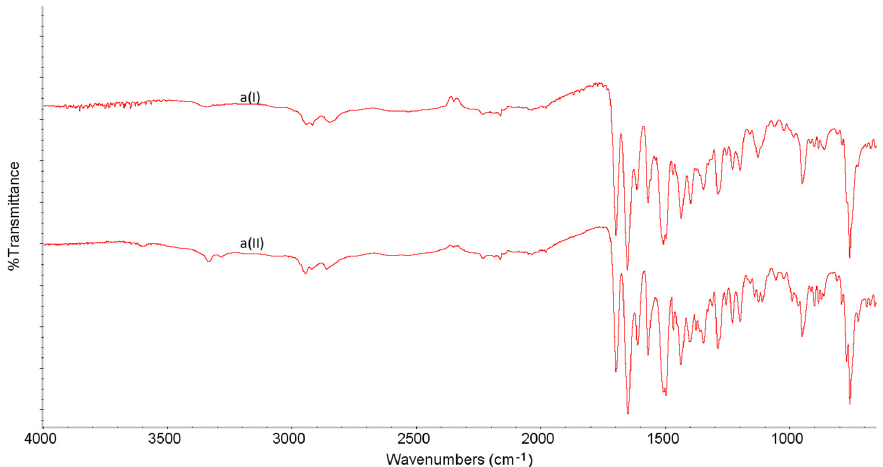
Figure 4 . FT-IR spectra for linagliptin (a) in the non-stressed (I) and stressed (II) samples. Figure 4. FT-IR spectra for linagliptin (a) in the non-stressed (I) and stressed (II) As far as excipients are concerned, LAC, MAN and MGS did not show changes under stress conditions. However, slight changes were observed in the spectrum of PVP, espe- cially in the region 1600–1500 cm − 1 (Figure 5).